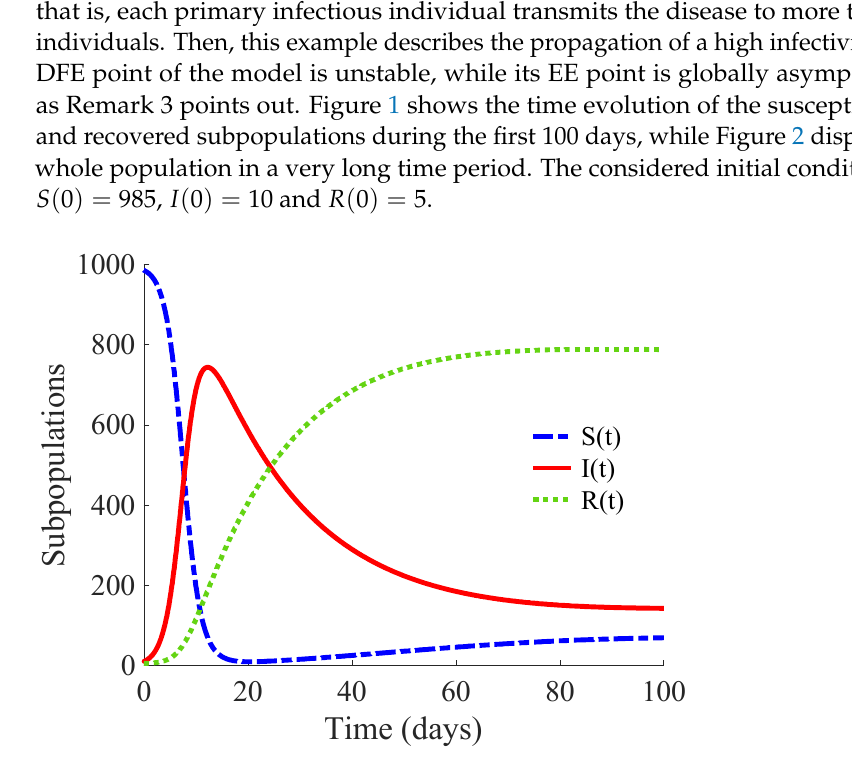
Figure 2. Time evolution of the whole population in the SIRS model without control actions. In the longer simulation, one can see that the model tends to an EE point where the number of individuals is 𝑁 (cid:3006)(cid:3006) = 877 with 𝑆 (cid:3006)(cid:3006) = 62 , 𝐼 (cid:3006)(cid:3006) = 127 and 𝑅 (cid:3006)(cid:3006) = 688 accord- ingly to (14), (15) with 𝑐 (cid:3036) = 0 , for 𝑖 ∈ (cid:4668)1, 2, … , 6(cid:4669) . Although the mortality rate due to the disease 𝛼 = 5 × 10 (cid:2879)(cid:2873) 𝑑 (cid:2879)(cid:2869) is not very high, the influence of the disease is very important, since the whole population notably decreases from 1000 individuals to 877. Moreover, the percentage of infectious individuals with respect to the whole population in the EE point is 14.48%. In this situation, the application of control measures is crucial in order to elim- inate the infection or, at least, to diminish its effect within the host population while re- ducing drastically the mortality. 3.2. Example 2: SIRS Model with Vaccination and Treatment Models (1)–(3) with the same values for the parameters 𝑏 , 𝜇 , 𝛽 , 𝛾 , 𝜌 and 𝛼 as those given in Example 1 are considered. Moreover, a vaccination for newborn individu- als together with the control actions (4) and (5) are applied in order to diminish the effects of the infectious disease. Concretely, the control actions are (i) a vaccination of a proportion 𝑞 = 0.1 of the newborn individuals ; i.e., 10% of newborns are vaccinated, (ii) a vaccination of the susceptible population given by (4) with the values 𝑐 (cid:2869) = 25 , 𝑐 (cid:2870) = 1 , 𝑐 (cid:2871) = 0.0001